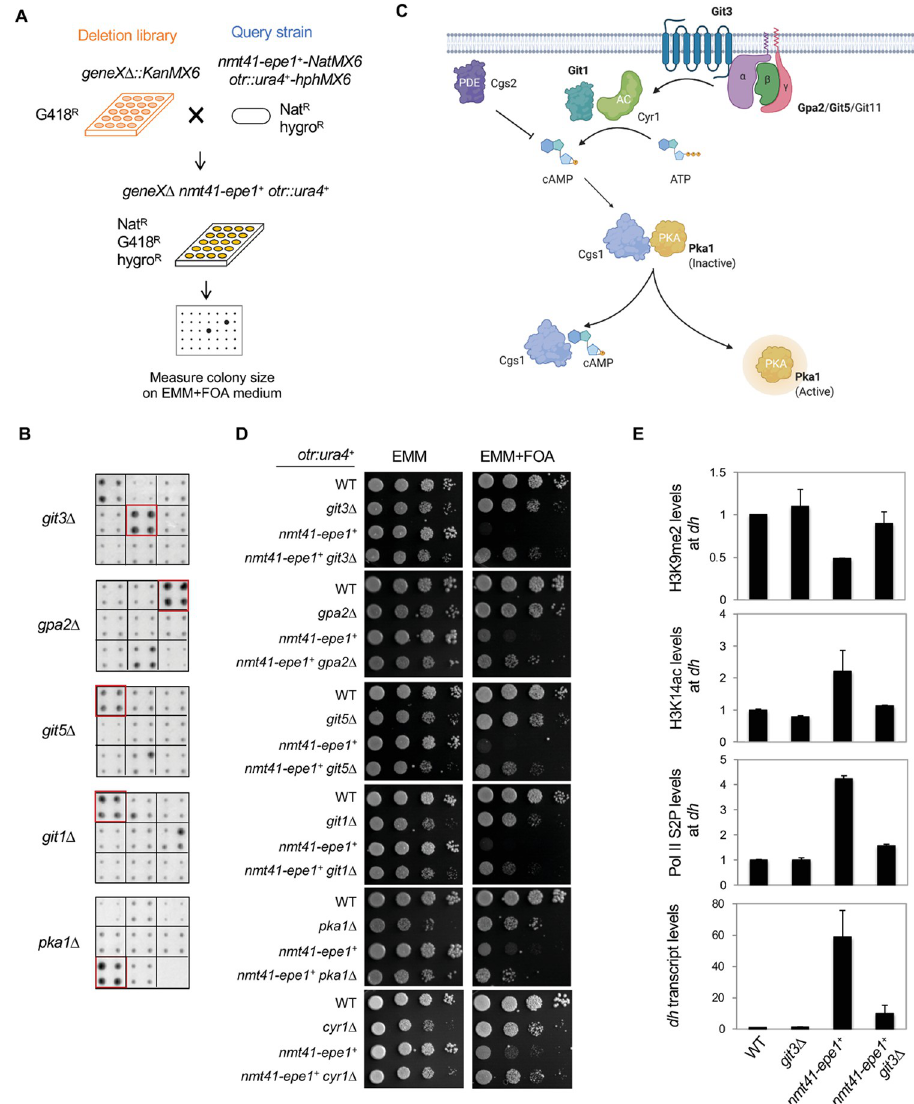
Fig 1. A genetic screen for regulators of Epe1 function. (A) Workflow to introduce otr :: ura4 + and nmt41-epe1 + into the deletion library. (B) Representative images of cells grown on EMM+FOA medium. Each square represents one gene deletion in quadruplicates. Red boxes represent cells with genotypes marked on the left. (C) Diagram of the cAMP signaling pathway in S . pombe . The factors identified in our screen are in bold. (D) Ten-fold serial dilution analyses of indicated yeast strains grown on indicated media to measure the expression of the otr :: ura4 + reporter. (E) ChIP analyses of H3K9me2, H3K14ac, and Pol II S2P levels at pericentric repeats ( dh ), normalized to leu1 + , and RT- qPCR analysis of pericentric transcript ( dh ), normalized to act1 + . Error bars represent SD, n � 3.